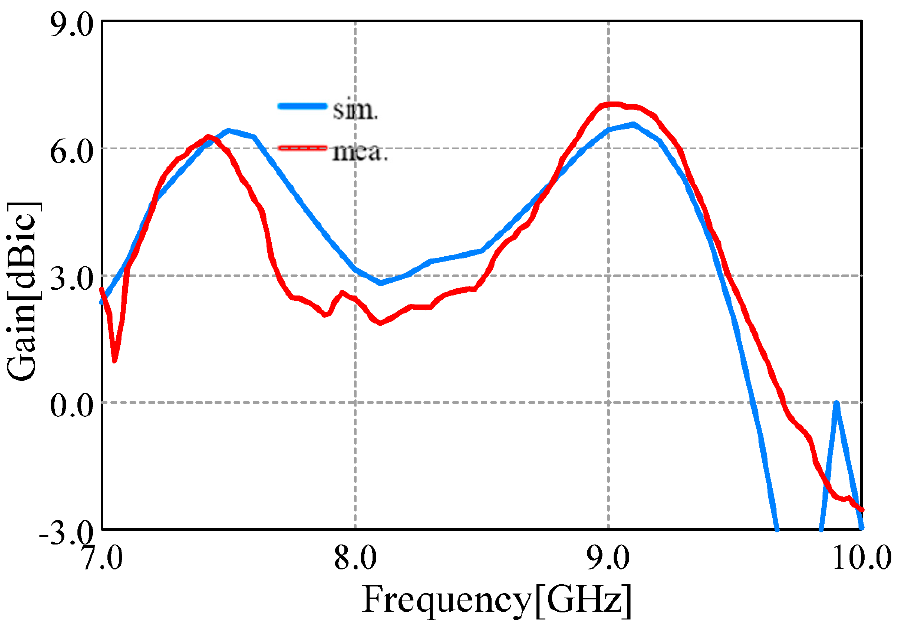
Figure 13. Measurement and simulation results for the gain frequency characteristics.